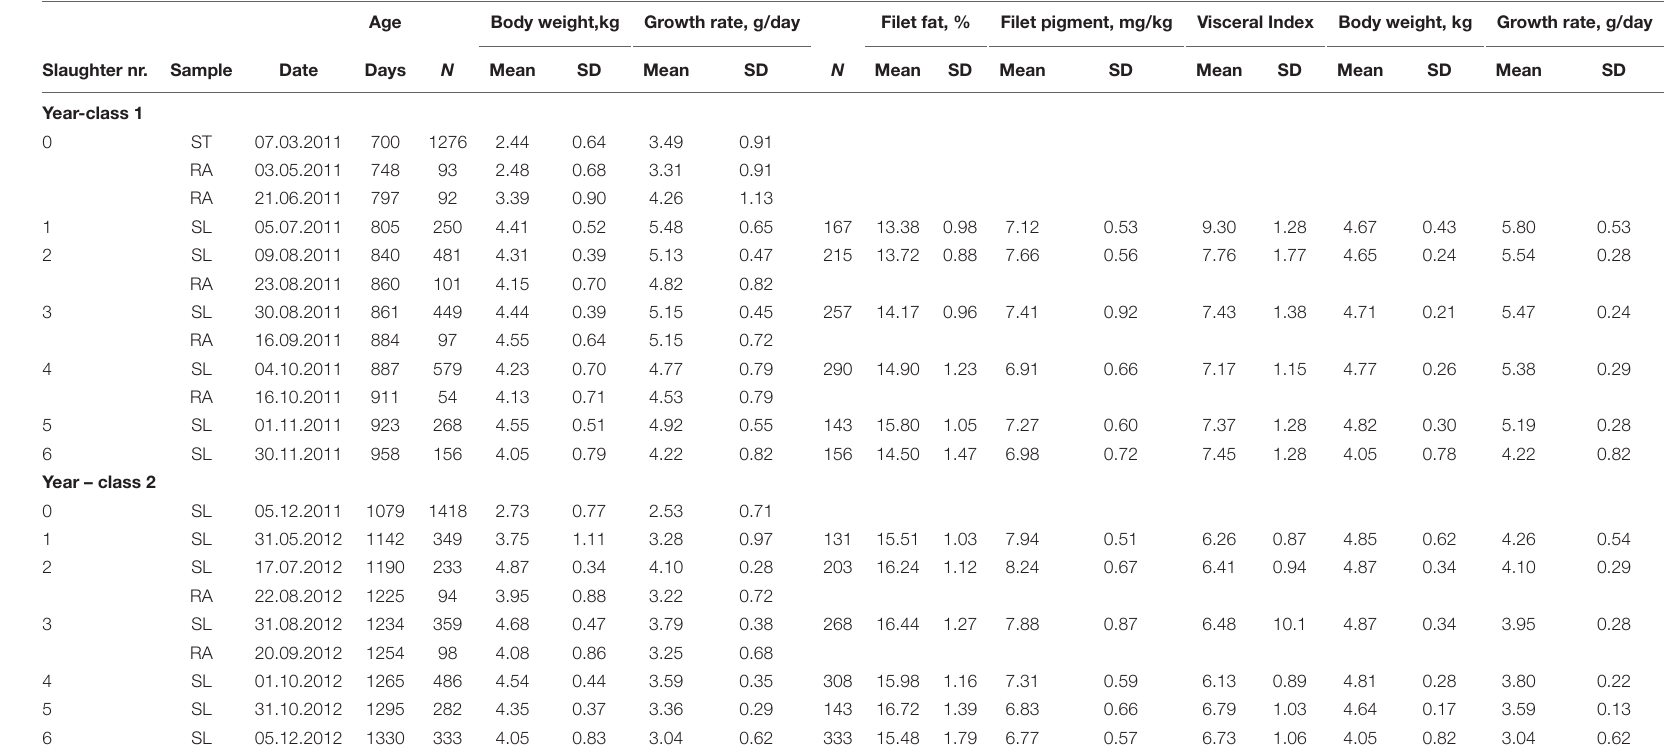
TABLE 1 | Descriptive statistics of the studied traits for each year-class and experimental group of the SW group at each sampling and slaughter date. Age Body weight,kg Growth rate, g/day Filet fat, % Filet pigment, mg/kg Visceral Index Body weight, kg Growth rate, g/day Slaughter nr.